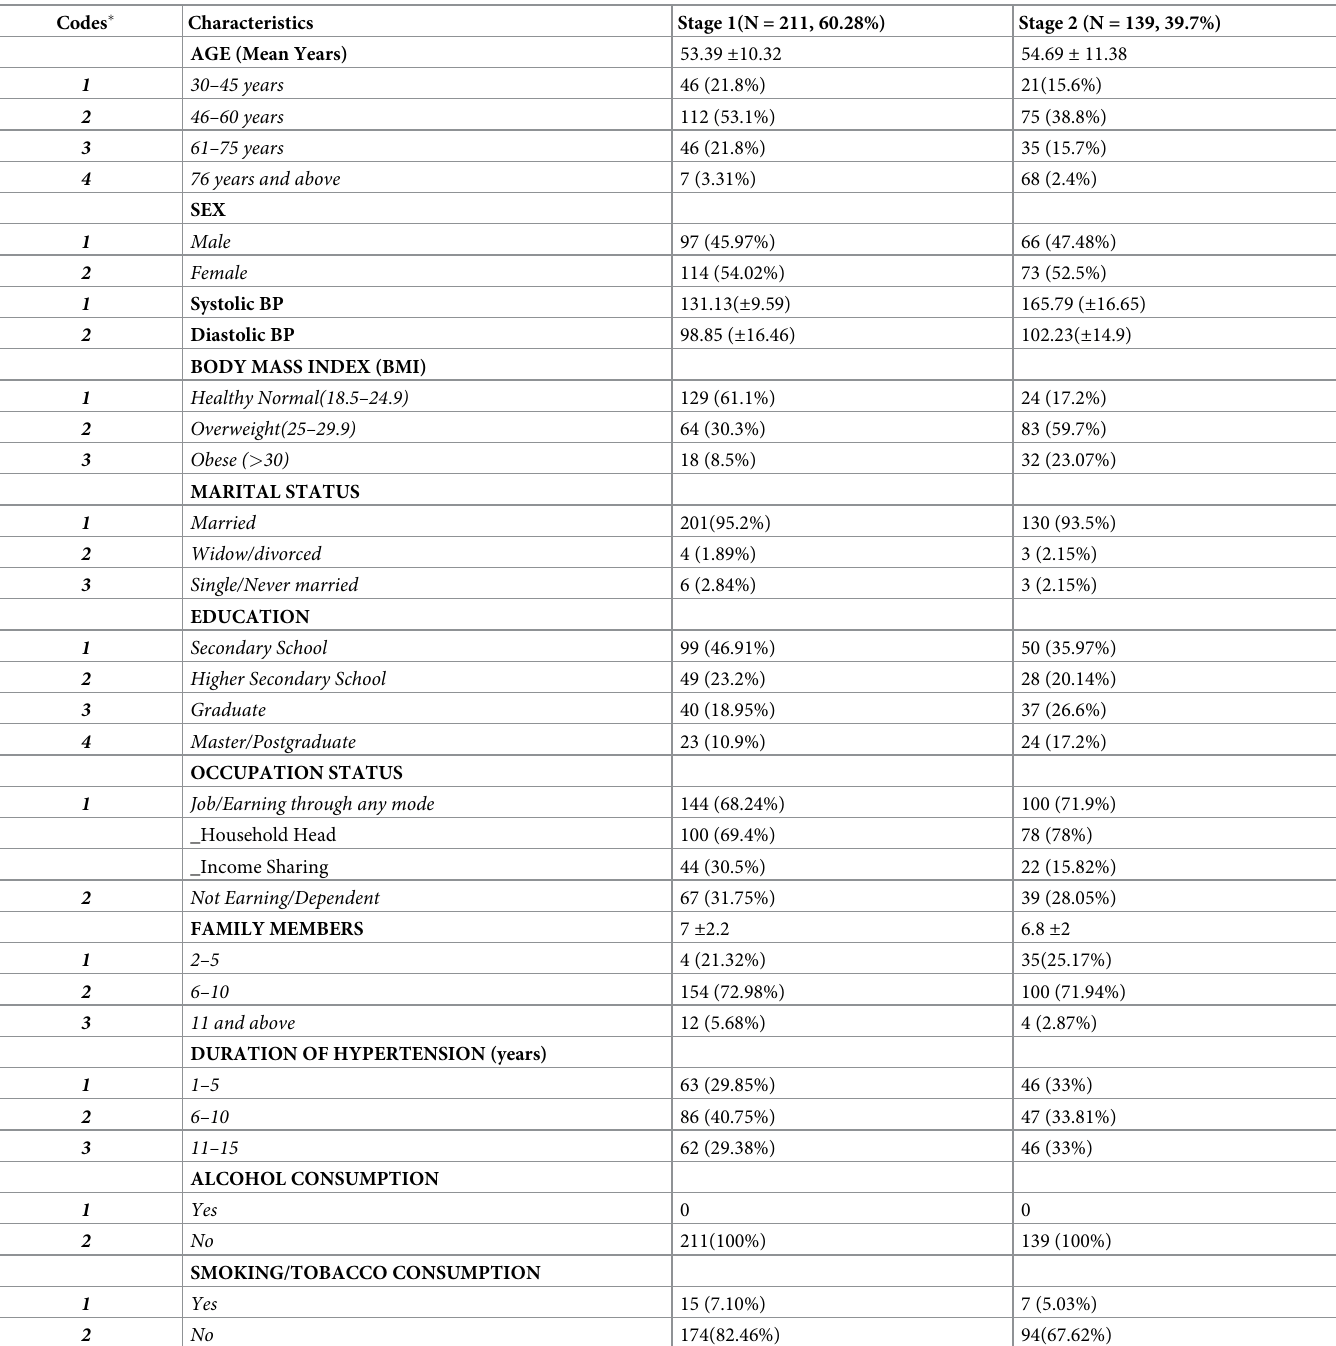
Table 1. Socio-demographic